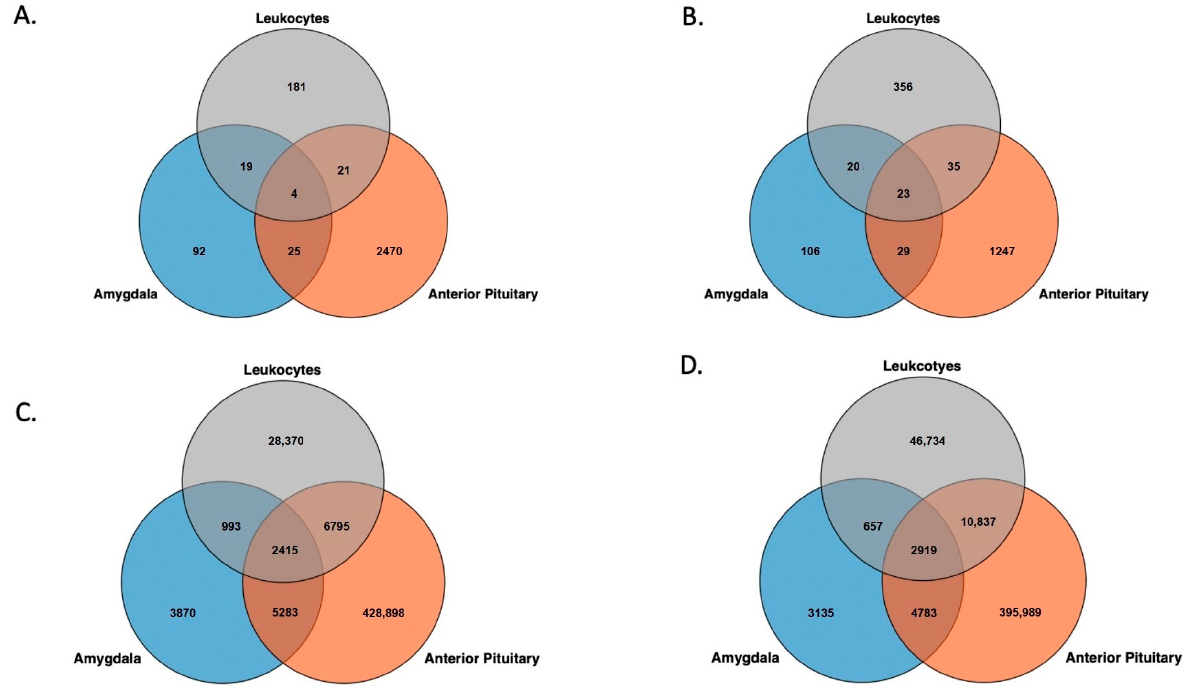
Figure 4. Overlap of genome wide cytosine-phosphate-guanine sites with a beta value standard deviation ≥ 0.1 across the tissues and leukocytes in the ( A ) Control and ( B ) Prenatally Stressed group and cytosine-phosphate-guanine sites with a p ≤ 0.001 for the chi-square test for the variance in the ( C ) Control and ( D ) Prenatally Stressed group.